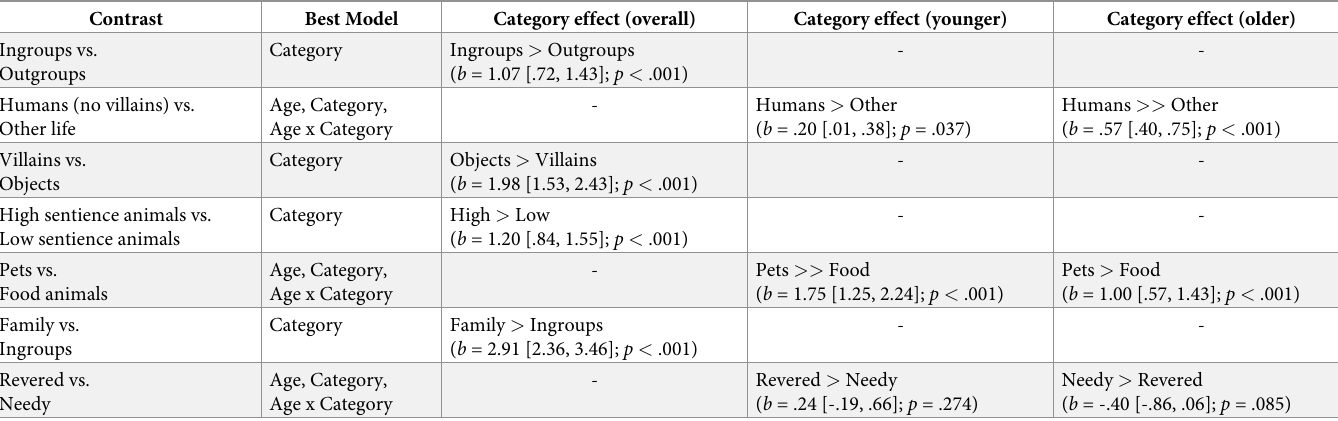
Table 1. Summary of planned contrast